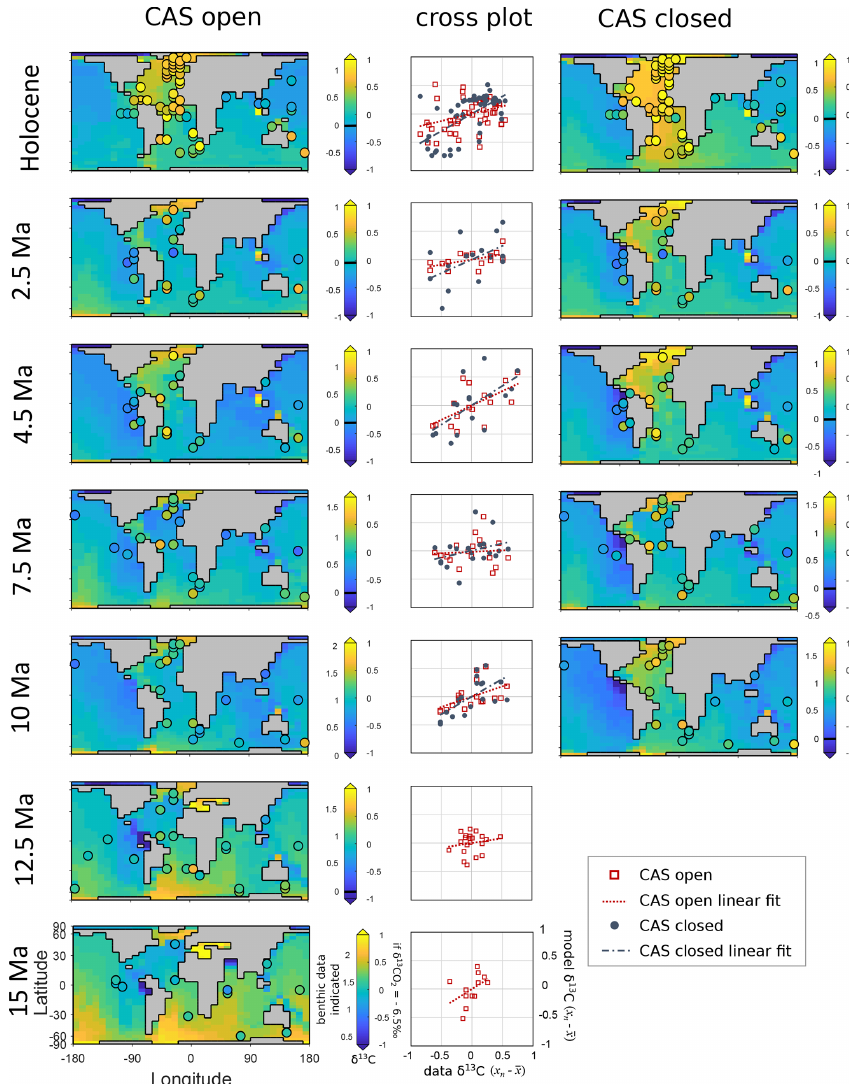
Figure 11. Modelled δ 13 C of dissolved inorganic carbon (DIC) for the best fit model settings, with data overlaid as shaded circles, and cross plots of mean-adjusted data points ( x axis) and mean-adjusted model points ( y axis). Note that shading is with respect to an atmospheric δ 13 CO 2 forcing of − 6 . 5‰. This shading allows the comparison of the benthic ocean δ 13 C patterns between the time slices. The data- indicated δ 13 C value is shown to the left of each colour bar. The model–data fit statistic (M-score) is shown in Fig.